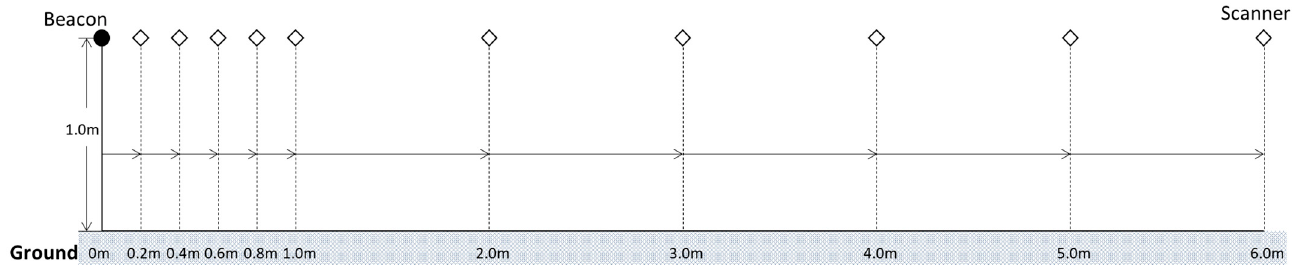
Figure 7. Distance between the beacon and scanner in the measurements.